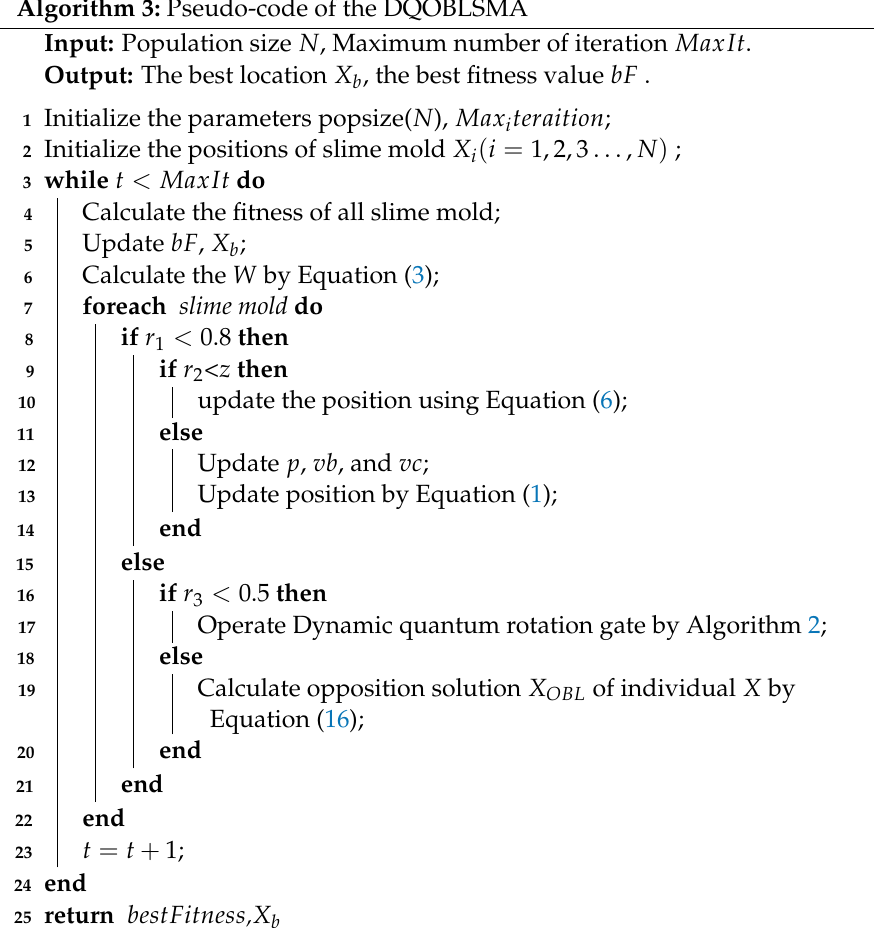
Algorithm 3: Pseudo-code of the